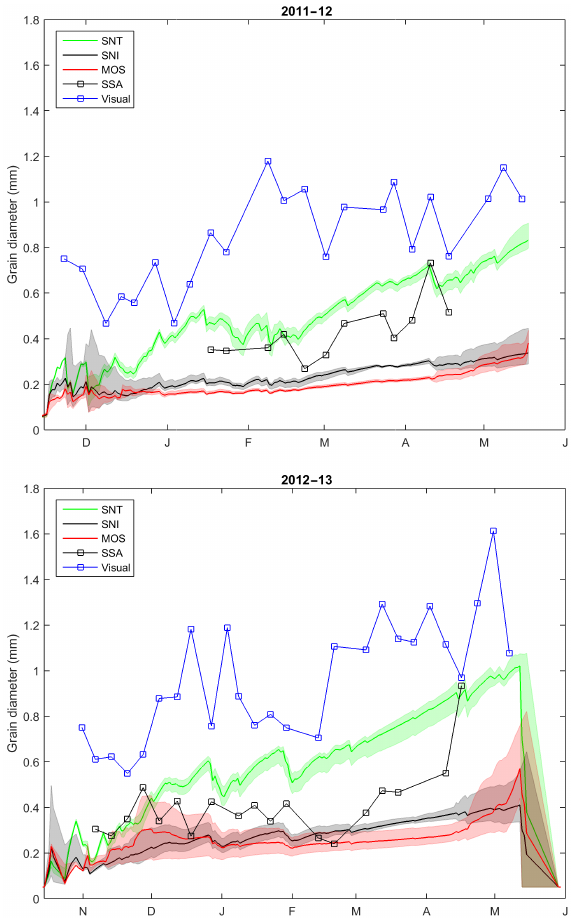
Figure 4. Bulk grain diameter evolution for the MOS, SNT, and SNI microstructure evolution models and the spread in model re- sults. Observations of bulk diameter were derived from macro- photography (Visual) and from SSA measurements from the Ice- Cube instrument. Table 3. Comparison of grain diameters simulated by different mi- crostructure models. The mean and max ratio between pairs of mod- els is given in columns. Where the 2012–2013 values differ, these are given in parentheses.